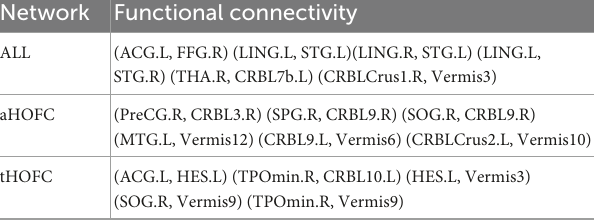
TABLE 2 Features selected for